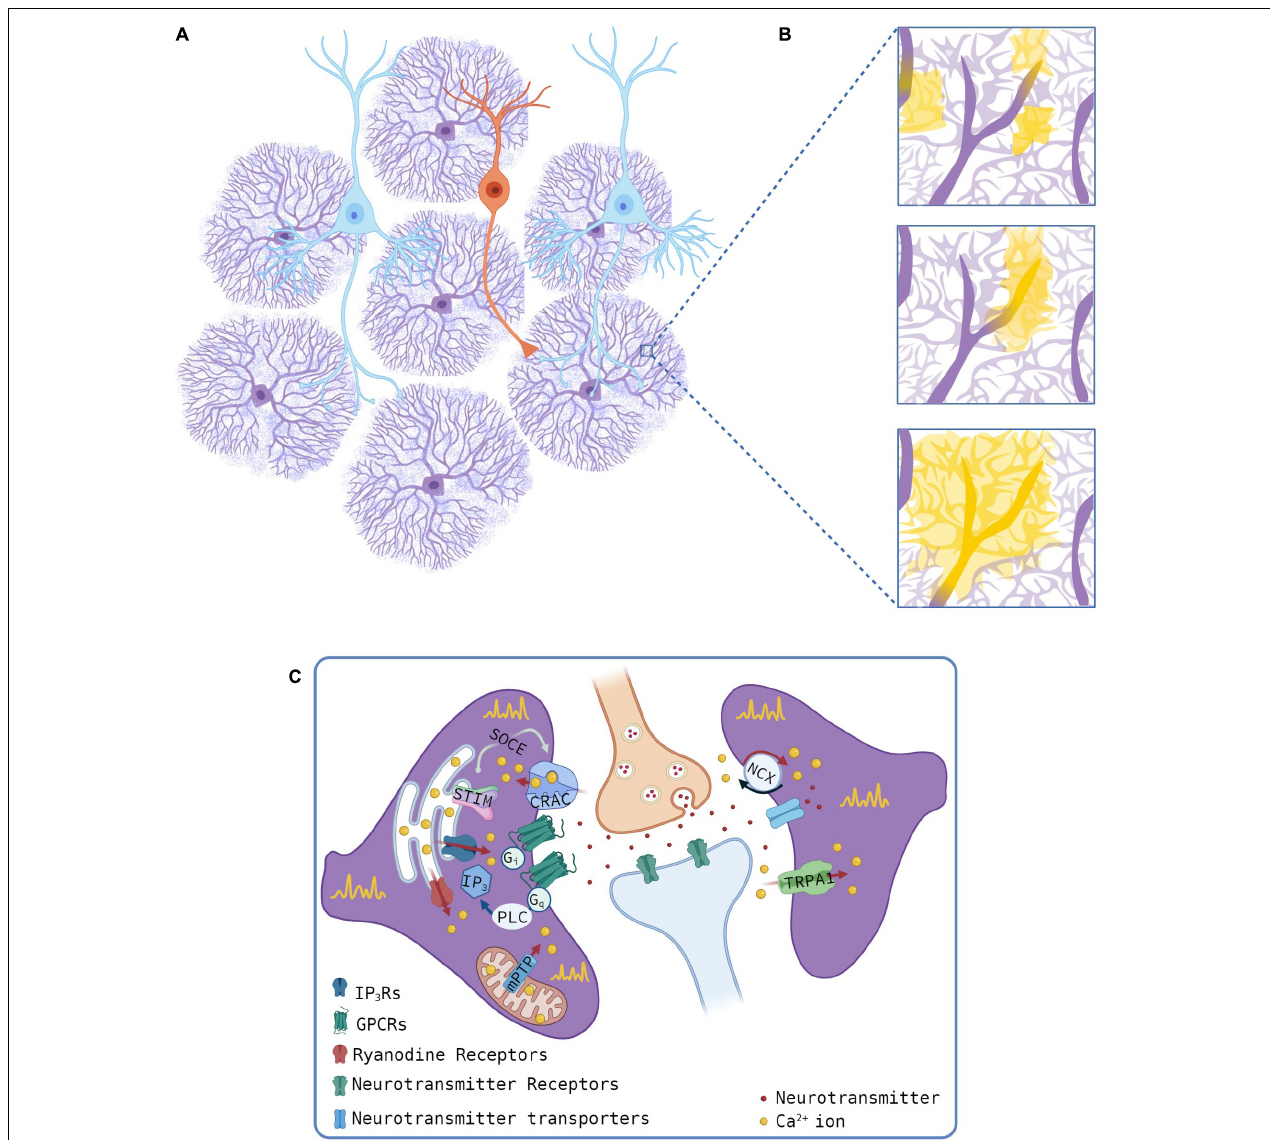
FIGURE 1 | Sources of Ca 2 + transients at microdomains. (A,B) Schematic of astrocyte-neuron network ( A , pyramidal neurons, cyan, and interneuron, orange) and microdomain Ca 2 + events (B) . Yellow regions for different Ca 2 + events, as observed with optical microscopy, and the presumed thin processes (light purple) as revealed by super-resolution imaging studies. (C) Mechanisms of astrocyte Ca 2 + transients at microdomains showing intracellular (left) or extracellular (right) Ca 2 + sources. Gliotransmitters are omitted. Created with